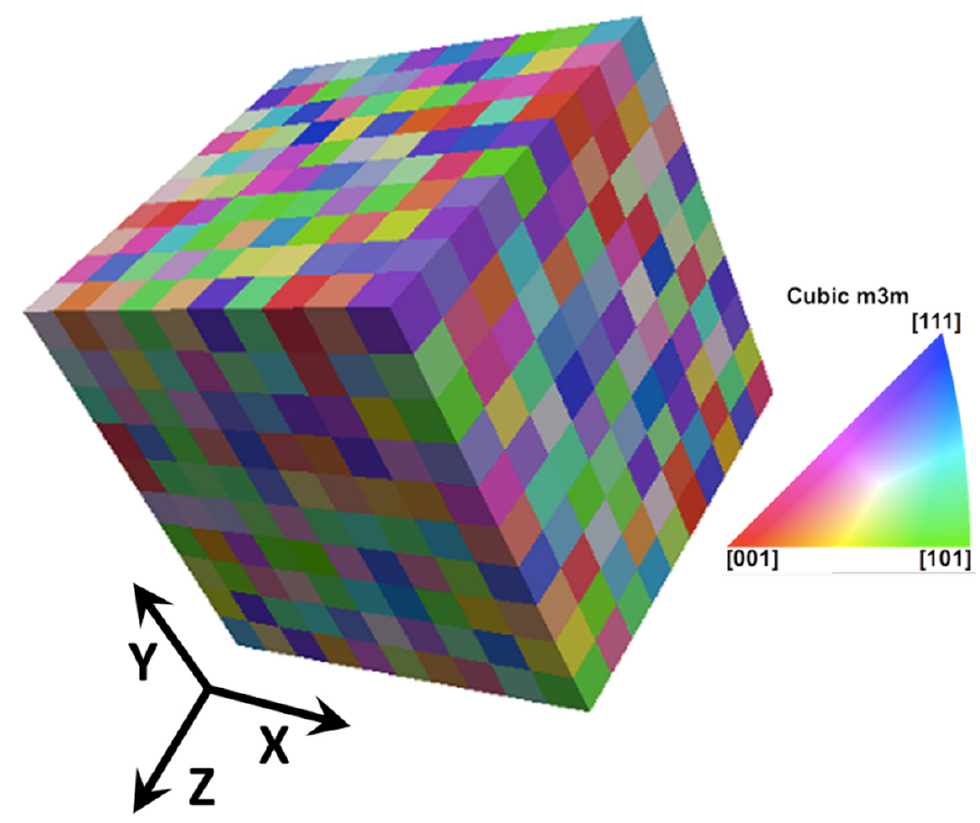
Figure 2. A single ‐ phase isotropic RVE [14] is shown, where each color represents a different grain according to the given IPF legend along the z ‐ axis.